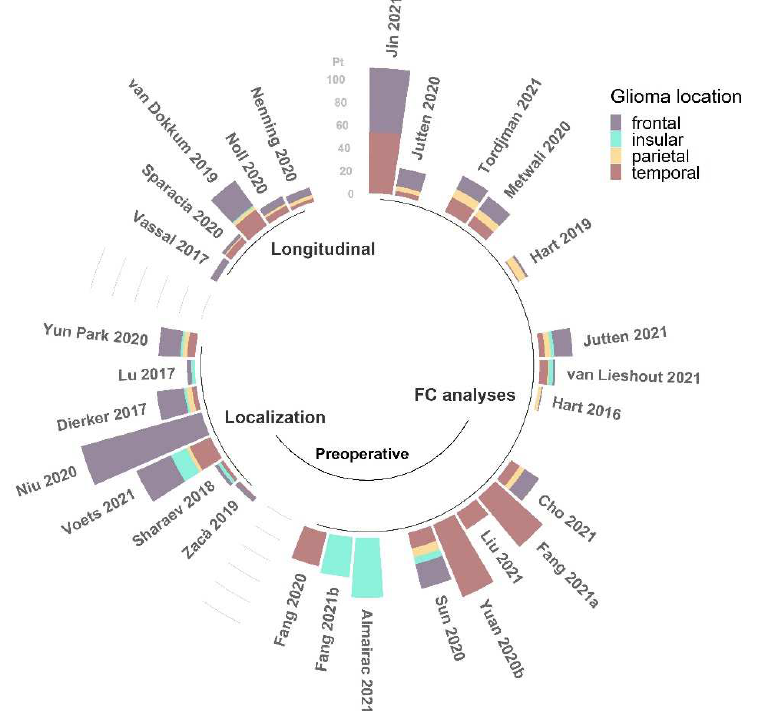
Figure 3. Number of patients (pt) with frontal, insular, parietal, and temporal glioma locations